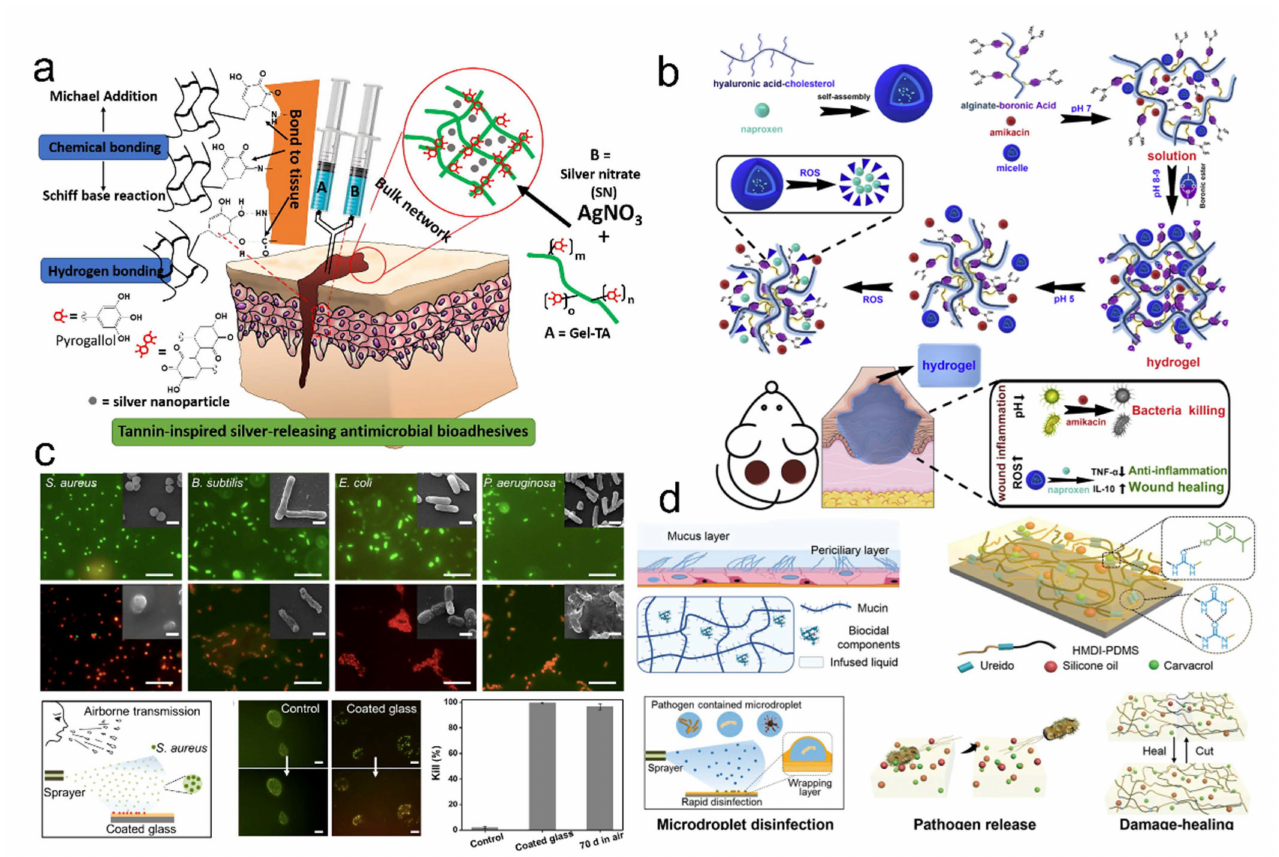
Figure 2. Biocide-releasing of antimicrobial adhesives. ( a ) Adhesive Gel-TA was prepared from the tannic acid and silver nanoparticles, demonstrating wet adhesion properties and inherent